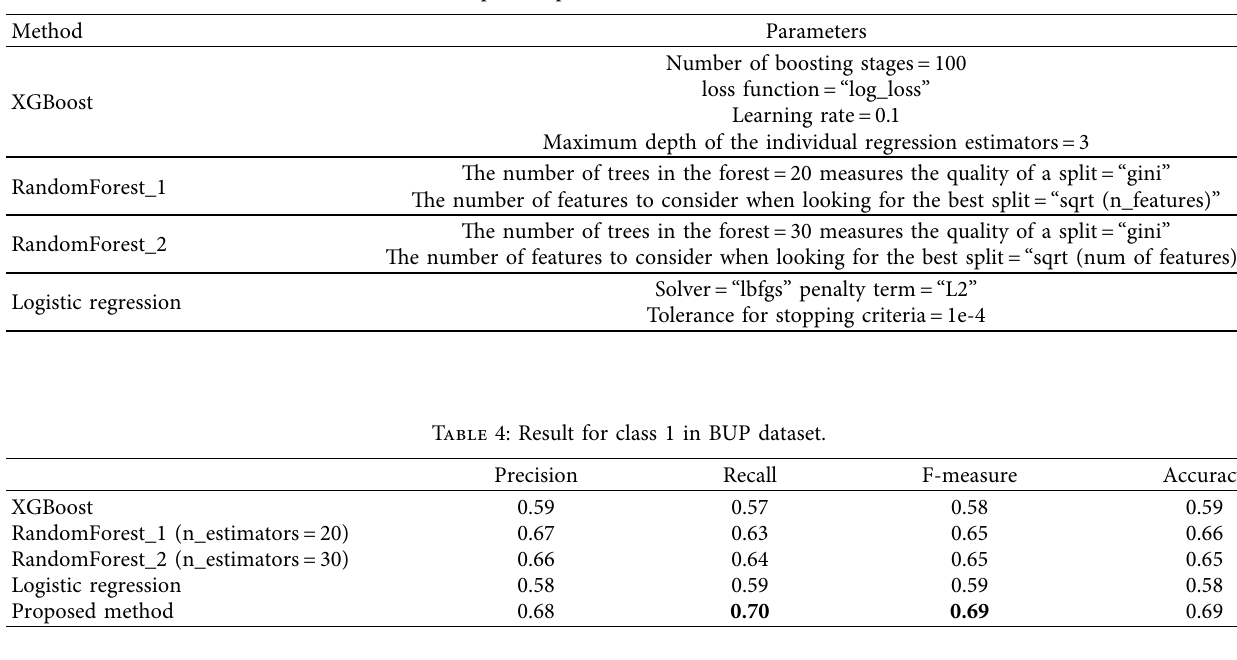
Table 3: Some of important parameters considered for different methods.